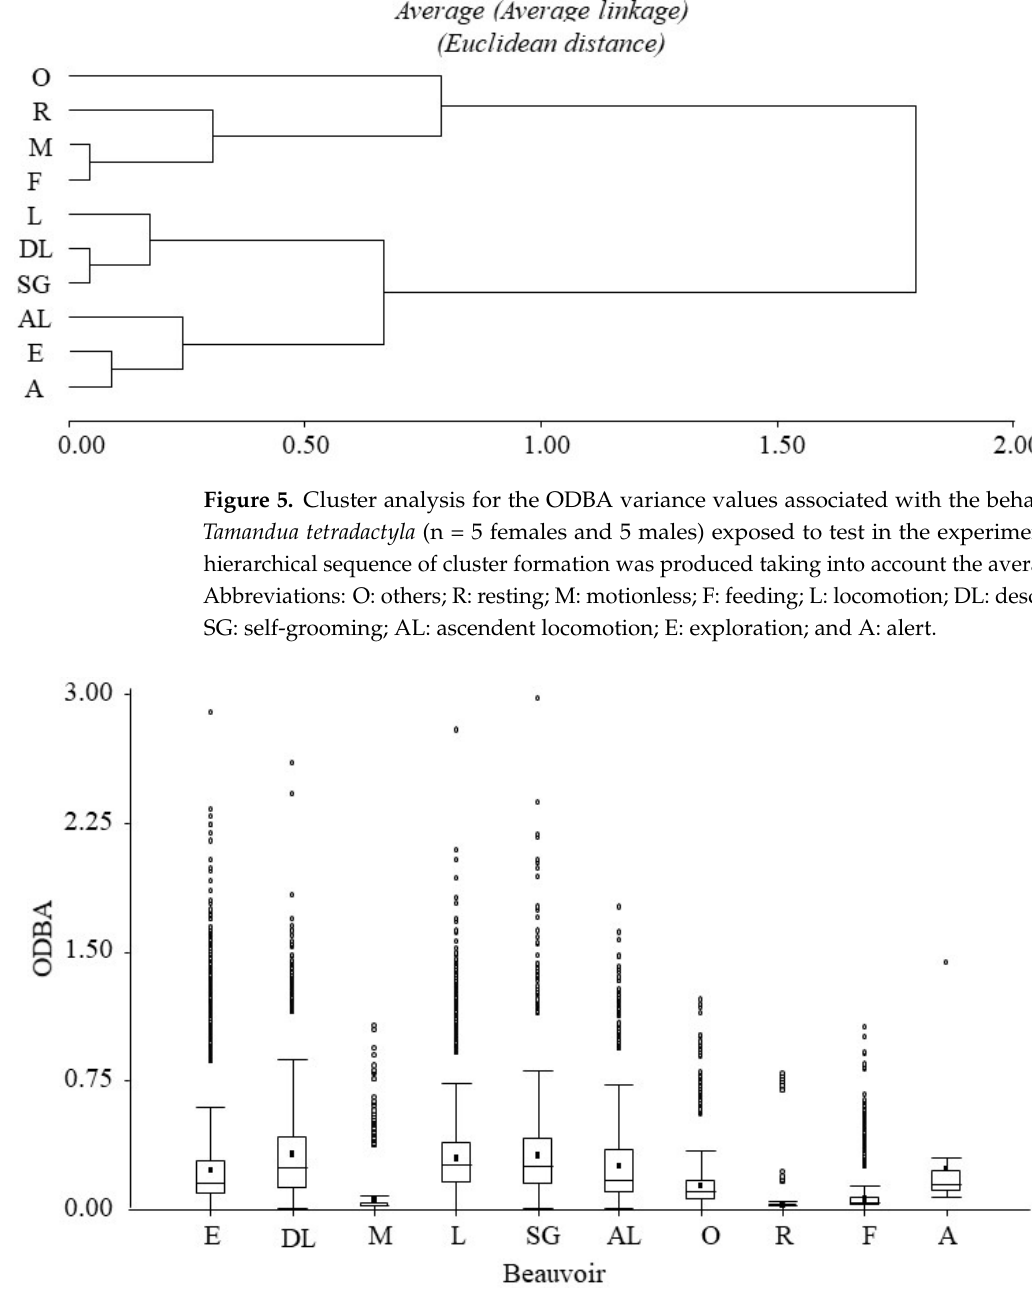
Figure 6. Overall dynamic body acceleration (ODBA) variance values of behaviours of adult Taman- dua tetradactyla (n = 5 females and 5 males) exposed to test in the experimental room. Behaviour was monitored continuously by means of a tri-axial accelerometer. Box plots show median values (horizontal line), average (dark square dot), 25th and 75th percentiles (bottom and top lines), SD ± 1 (whiskers) and values outside the range (black circles). Abbreviations: O: others; R: resting; M: mo- tionless; F: feeding; L: locomotion; DL: descent locomotion; SG: self-grooming; AL: ascendent loco- motion; E: exploration; and A: alert.